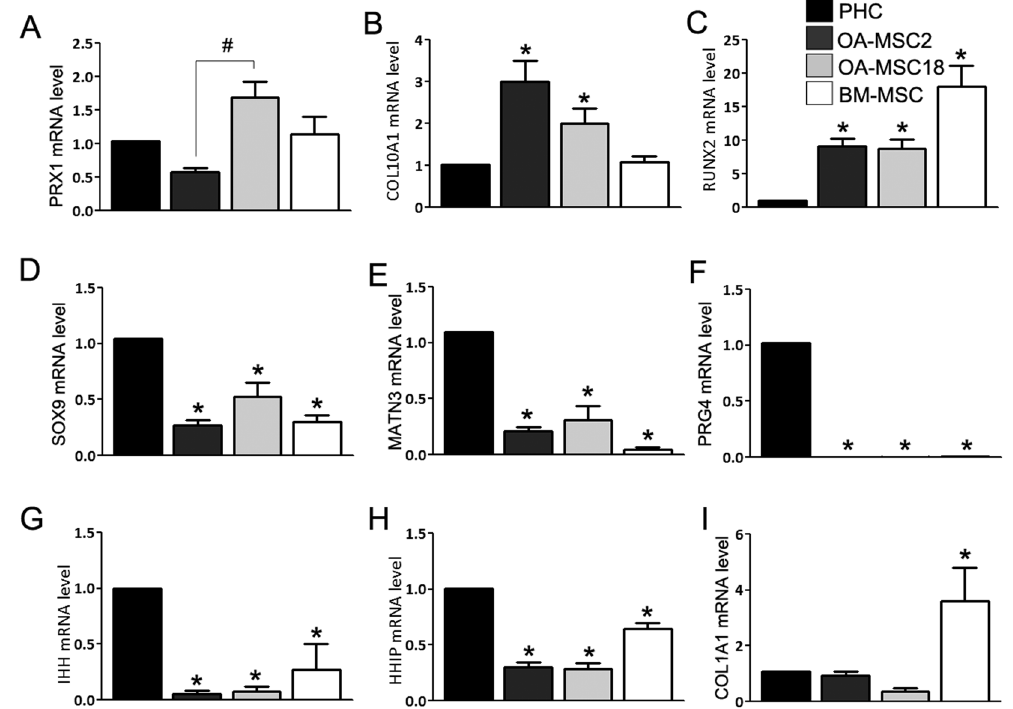
Figure 5. Comparison of gene expression profiles of clonal OA cartilage-derived MSCs, PHCs and BM-MSCs. (A) Relative mRNA expression mesenchymal transcription factor PRX1, (B) type X collagen (COL10A1), (C) RUNX2, (D) chondrogenesis transcription factor SOX9, (E) cartilage matrix protein matrilin-3, (F) cartilage surface lubricating protein PRG4, (G) Indian hedgehog (IHH), (H) hedgehog interacting protein (HHIP), (I) and stromal marker COL1A1, in primary human chondrocytes (PHCs), bone marrow mesenchymal stem cells (BM-MSCs), OA-MSC2 and OA-MSC18. n ≥ 3. * p ≤ 0.05, relative to the chondrocyte group. # p ≤ 0.05. Data are represented as mean ±